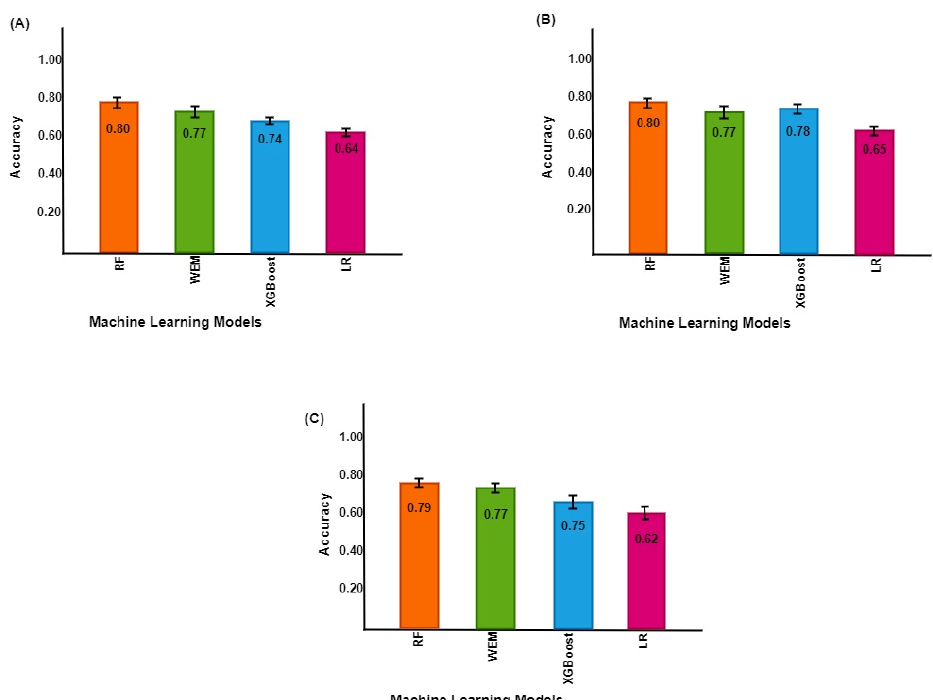
Figure 2. Uncontrolled DM prediction accuracy across models of machine learning in the AoU Research Program. The panel in the left top corner ( A ) shows the prediction accuracy of ML models for both genders. The right top corner ( B ) is the prediction accuracy for females, and the right lower panel ( C ) is the prediction accuracy for males.